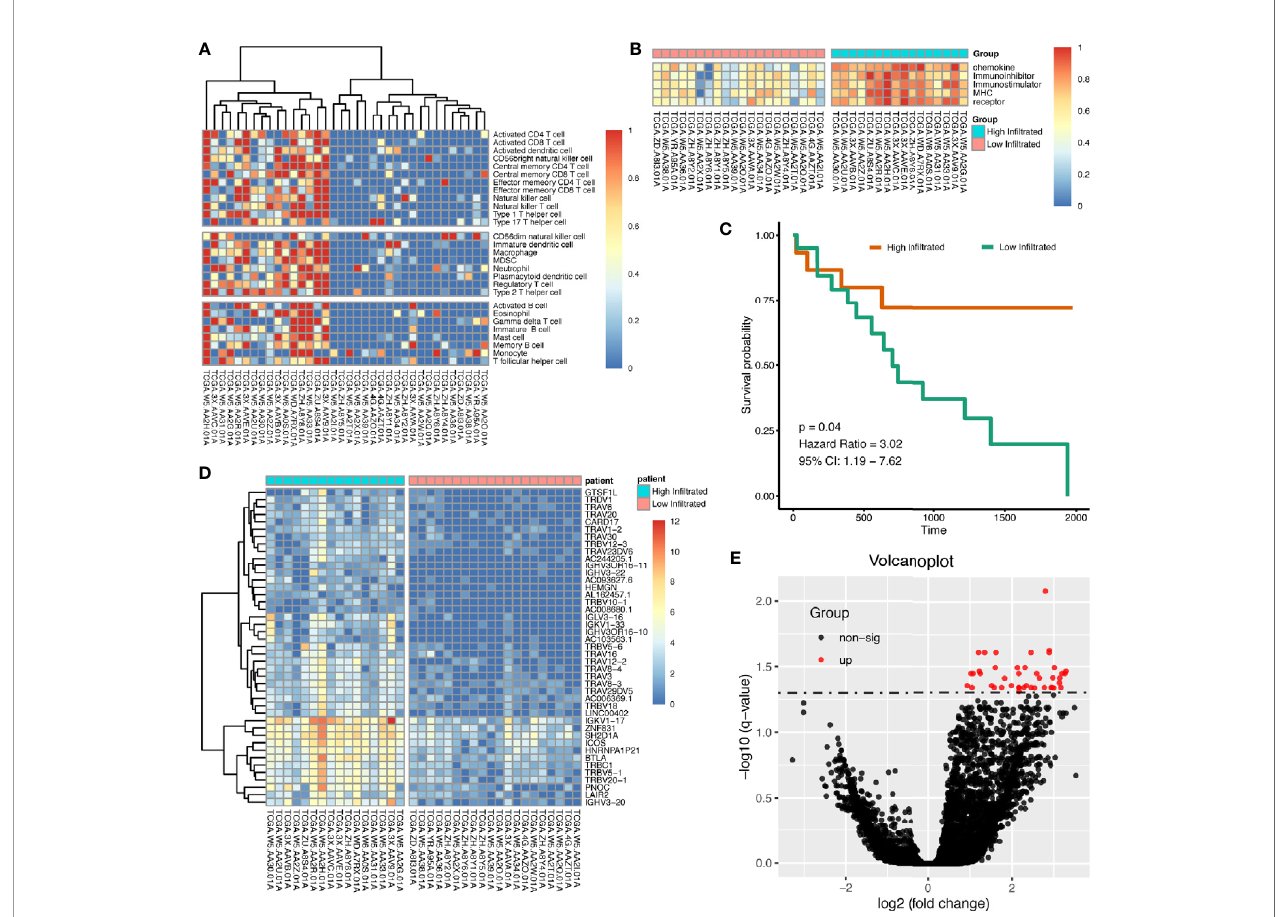
FIGURE 2 | Patients with cholangiocarcinoma were divided into differentially immune in fi ltrated groups with different prognosis. (A) Clustering of CCA patients according to immune in fi ltration status calculated by ssGSEA method. (B) Whole scores of chemokine, chemokine receptor, immune stimulator, immune inhibitor, and MHC expression levels between groups. (C) Survival difference between high- and low-immune in fi ltrated cholangiocarcinoma patients. (D, E) Differentially expressed genes between high- and low-immune in fi ltrated